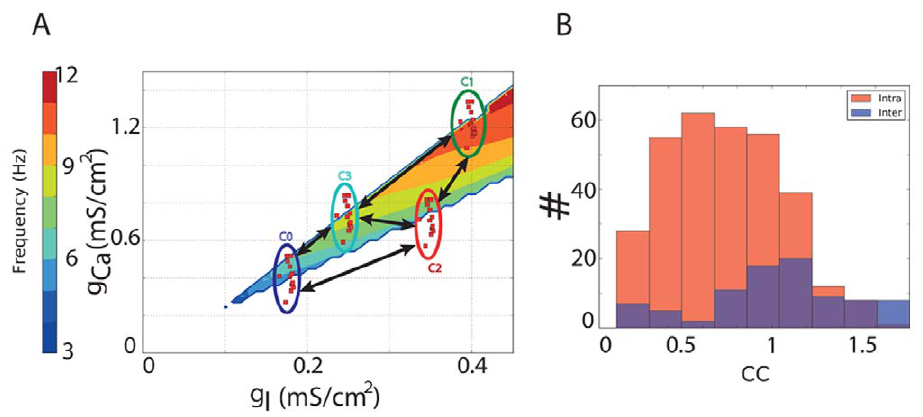
Figure 1. Proposed network architecture. A: Model neurons only contain leak and Ca 2 + currents and spontaneously oscillate at frequencies determined by the exact density of the associated conductances. Colors of the g l -g Ca plane indicate the frequency at which a model with the corresponding density of conductances oscillates; in the white region model neurons do not oscillate spontaneously. The network itself consists of individual neurons (red squares) grouped in clusters (colored ellipses; color not related to the frequency). Neurons inside the cluster are connected to 4 neighbors. When two clusters are connected (black arrows) each neuron from one cluster is connected to a random neuron in the other cluster. All connections are gap-junctions. B: Resulting coupling coefficients of all connections in the network. This specific network is used throughout the manuscript for demonstration purposes.